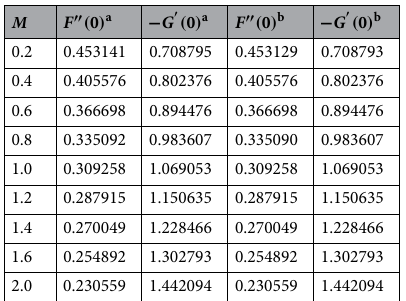
Table 1. A comparison of 45th order HAM results with those obtained by Ariel 24,41 for different values of M when K = 0 . a Shows results given in Ariel 41 . b Our results.